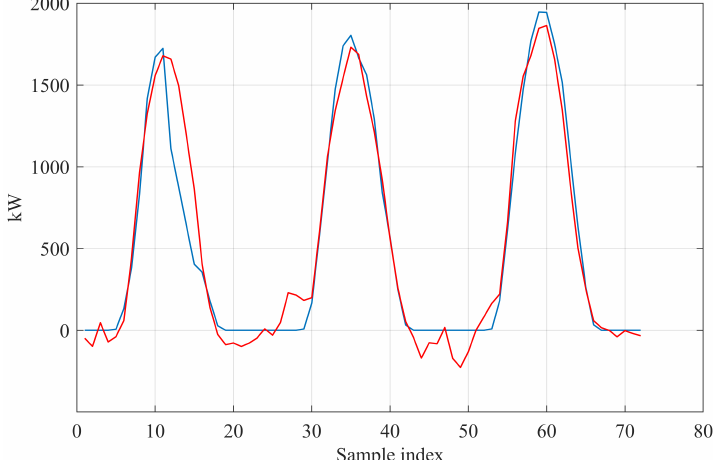
Figure 29. Actual (blue) and predicted (red) PV power in the middle of May 2016. Adapted with permission from [41], © 2018